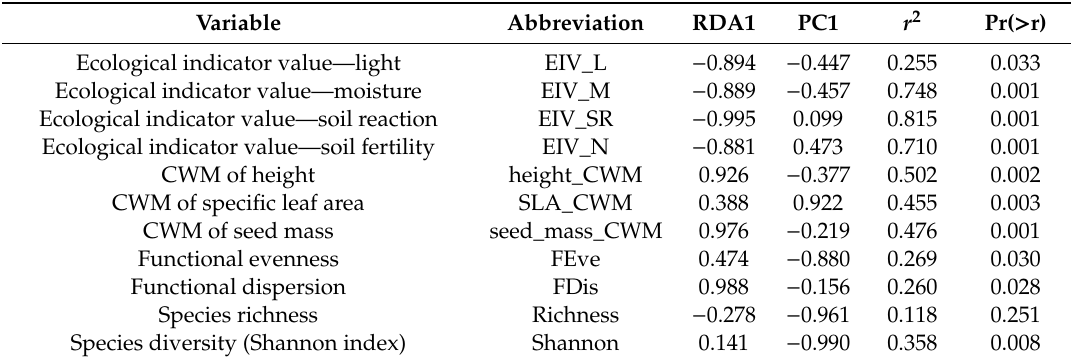
Table 6. Goodness of fit of passive projection of species composition to RDA result (Figure